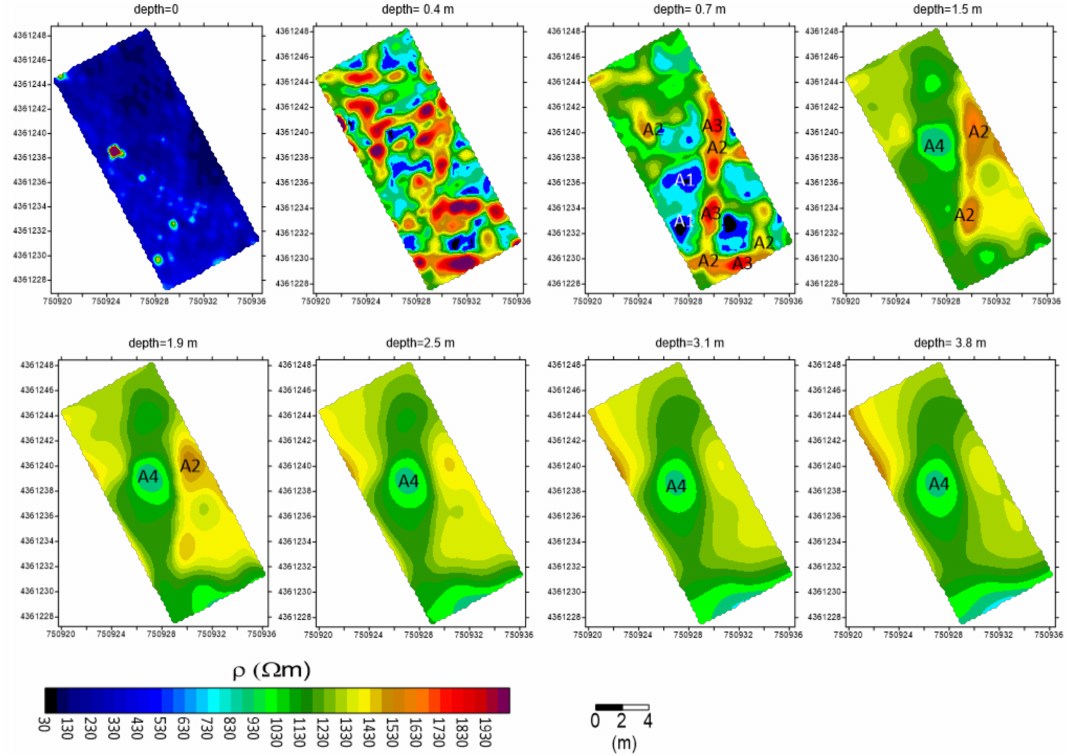
Figure 5. Slices at di ff erent depths from the three-dimensional (3D) inversion. The anomalies A1, A2, A3 and A4 from Figure 4 are